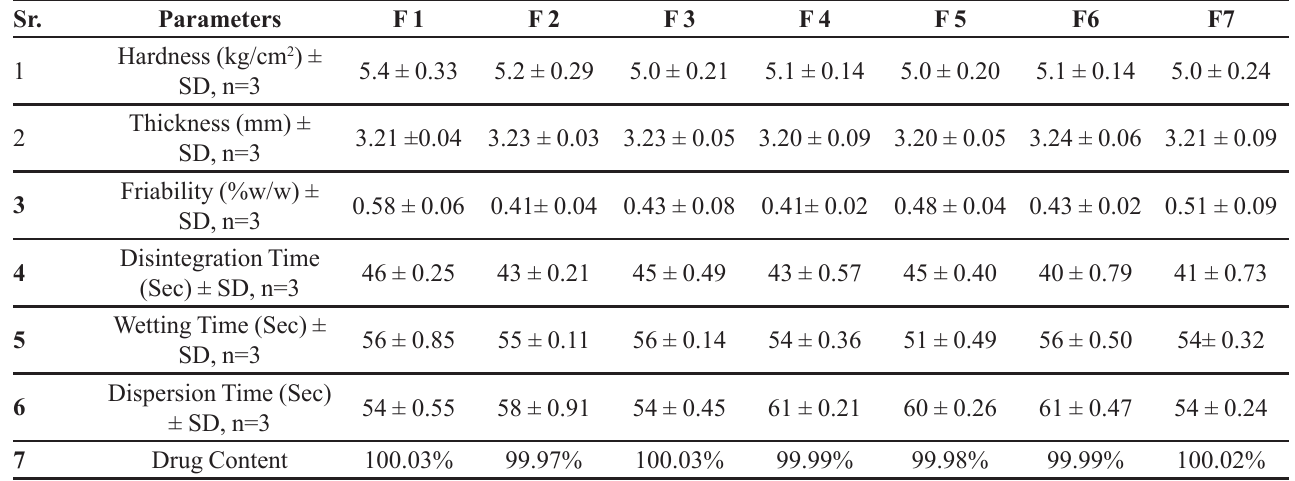
TABLE III - Post compression parameters of the formulations